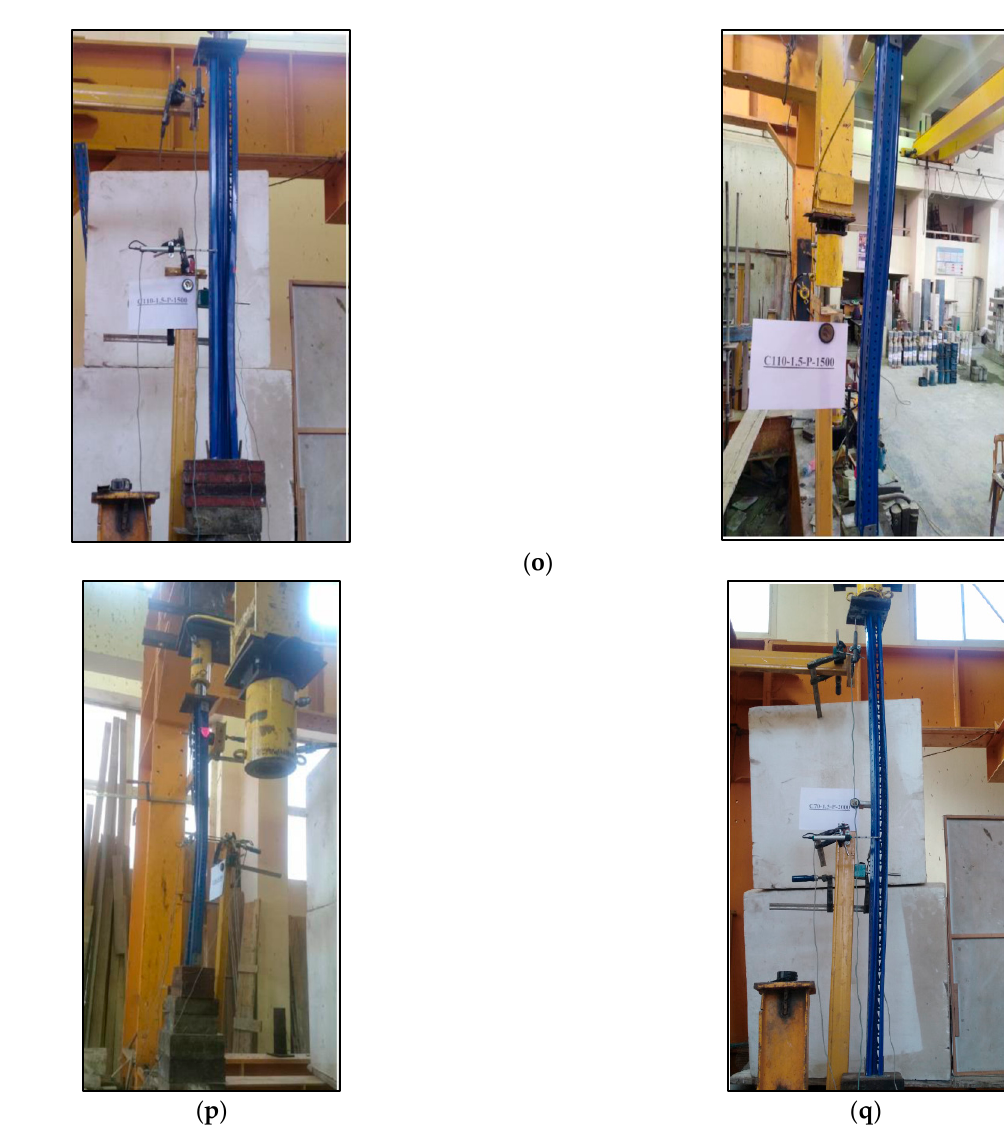
Figure 6. Pictures of the different specimens at collapse, during the experimental test. ( a ) C70 ‐ 63.5 ‐ 1.5 ‐ P ‐ 500 (DB); ( b ) C90 ‐ 80 ‐ 1.5 ‐ P ‐ 500 (DB); ( c ) C110 ‐ 80 ‐ 1.5 ‐ P ‐ 500 (DB); ( d ) C110 ‐ 80 ‐ 2 ‐ P ‐ 500 (DB); ( e )